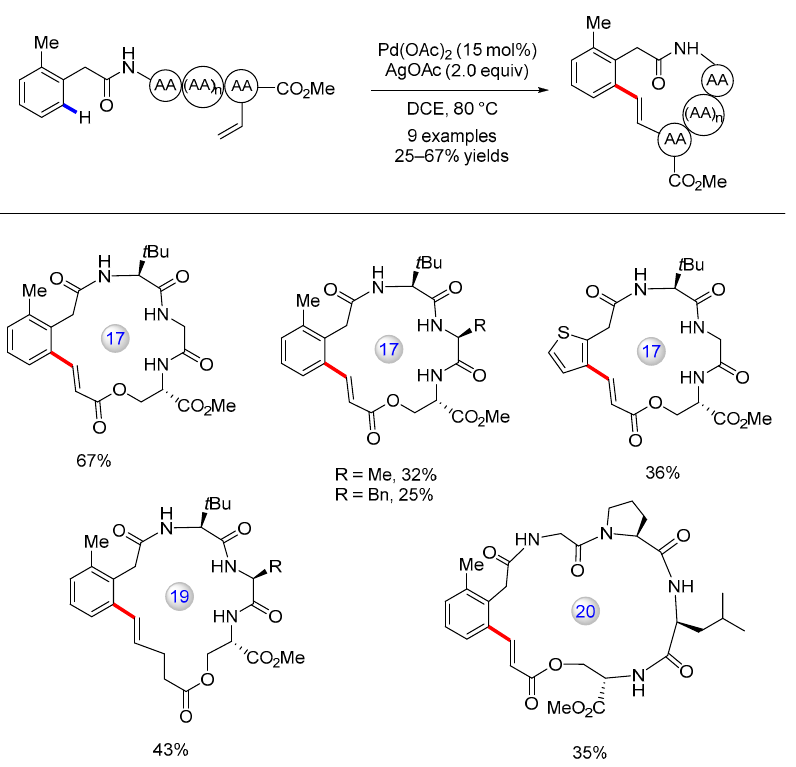
Figure 16. Macrocyclization via Pd(II)-catalyzed intramolecular C(sp 2 )–H olefination of peptidoarylacetamides [75].